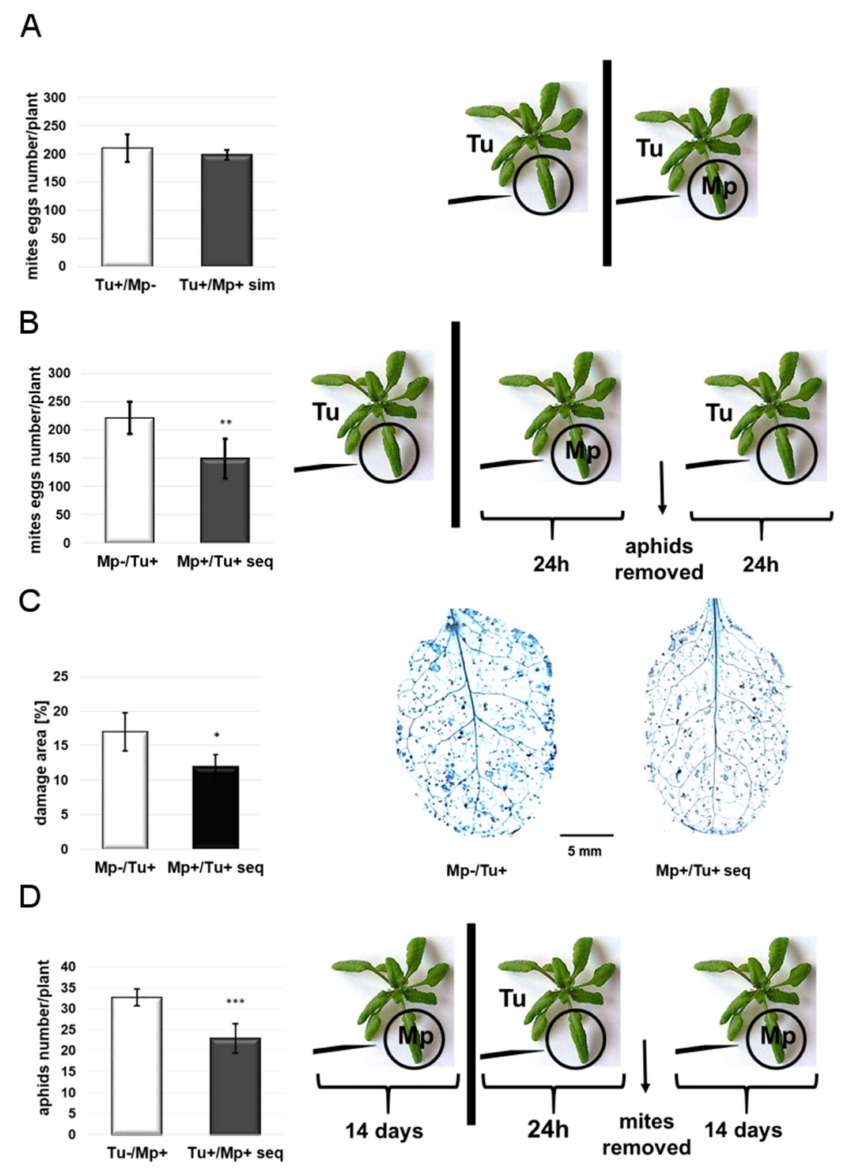
Figure 1. TSSM (Tu) and GPA (Mp) reproductive performance. ( A ) TSSM oviposition rate expressed as the number of mite eggs x plant -1 after simultaneous plants infestation with GPA and TSSM ( ± SD; n = 6). ( B ) TSSM oviposition rate expressed as the number of eggs × plant − 1 after sequential infestation of plants by GPA and TSSM ( ± SD; n = 6). ( C ) Mite-leaf damage visualization by TB staining assessment -extent of damage assessed by the percentage of damaged leaf area ( ± SD; n = 3). Scale bar indicates magnification. ( D ) The effect of TSSM infestation on GPA reproduction ( ± SD; n = 9). Asterisks indicate significant differences (the two-tailed— t -test) at p -values of <0.05 *; <0.01 **; <0.001